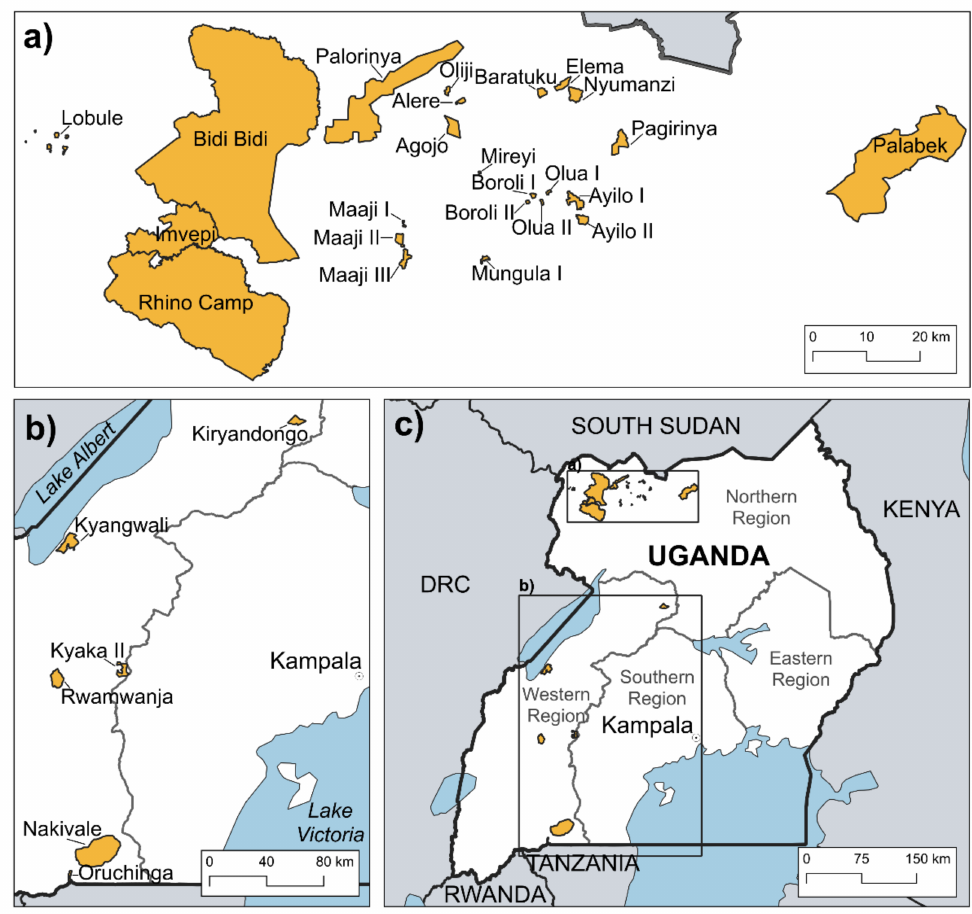
Figure 2. Thirty UNHCR-managed study refugee settlements in ( a ) northern and ( b ) western regions of ( c ) Uganda. DRC, Democratic Republic of the Congo. Table 1. Characteristics of 30 study refugee settlements in Uganda. Establishment year based on UNHCR settlement factsheets. Population data (as of September 2020) are from https://data2 .unhcr.org/en/documents/details/79424 (accessed on 1 December 2020). Settlement boundary areas are from https://data2.unhcr.org/en/documents/details/74116 (accessed on 1 December 2020), described below. Building footprint areas are based on 10-meter resolution OSM–MS building footprint data, described